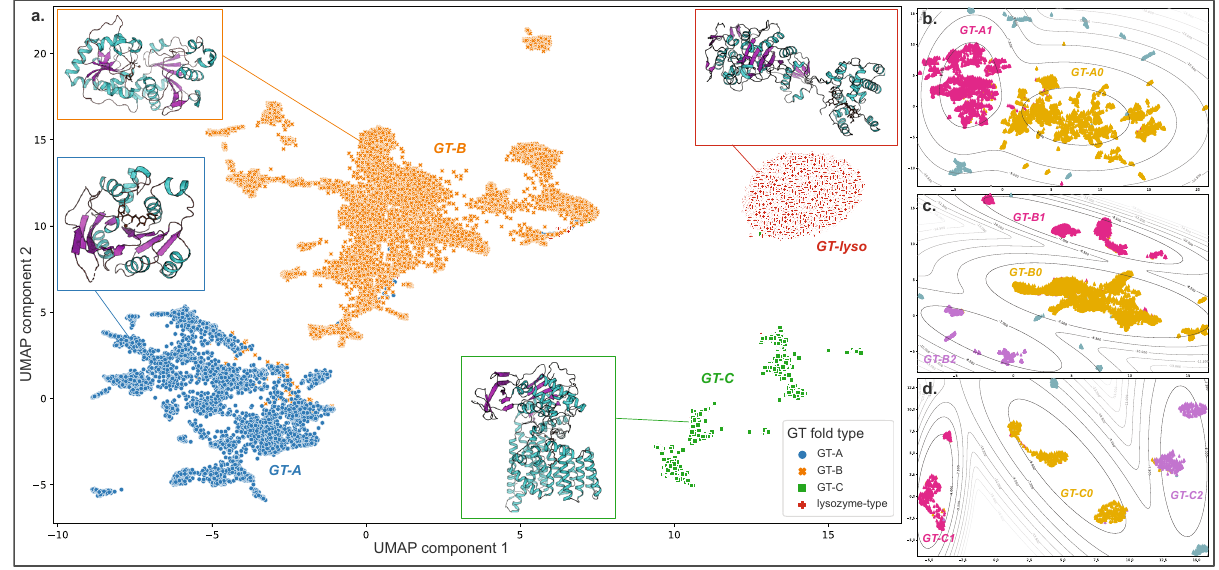
Fig. 2 UMAP projection shows the separation of the major GT fold types. Dots represent 2D UMAP projection of features for individual sequences. UMAP plot was generated across a scan of parameters (n_neighbors = 5, 15, 20 and min_dist = 0.001, 0.01, 0.1, 0.5) with three plots for each combination of parameters to ensure reproducibility (Supplementary Fig. 3). a Dots are colored based on their fold type and show a clear separation. Representative structures for each fold type are also shown. UMAP was applied separately on each major fold type and the projections for sequences belonging to the GT- A ( b ), GT-B ( c ), and GT-C ( d ) folds are shown. Clustering was done on these projections based on a Gaussian Mixture Model (GMM). Gray lines represent the contour for GMM scores around each cluster. Sequences that belong to a cluster are colored in yellow, magenta, or purple and are labeled with the cluster name. Sequences that do not belong to any cluster are colored in teal. Source data are provided as a Source Data fi